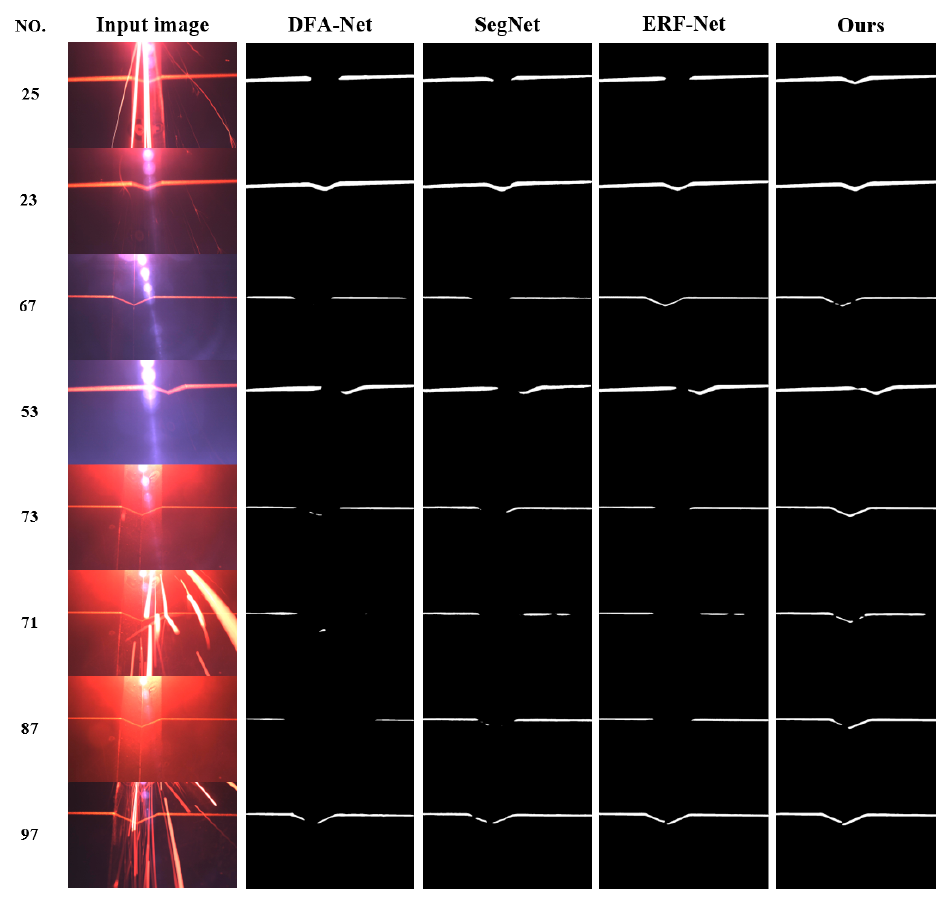
Figure 11. Comparison of the segmentation effects.